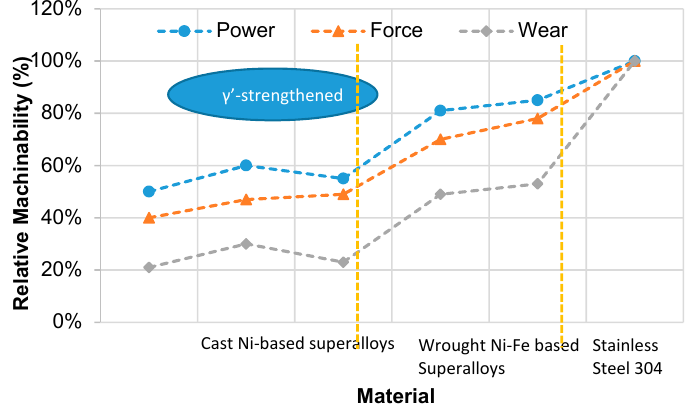
Figure 2. Machinability rankings for two classes of nickel-based superalloys relative to stainless steel 304